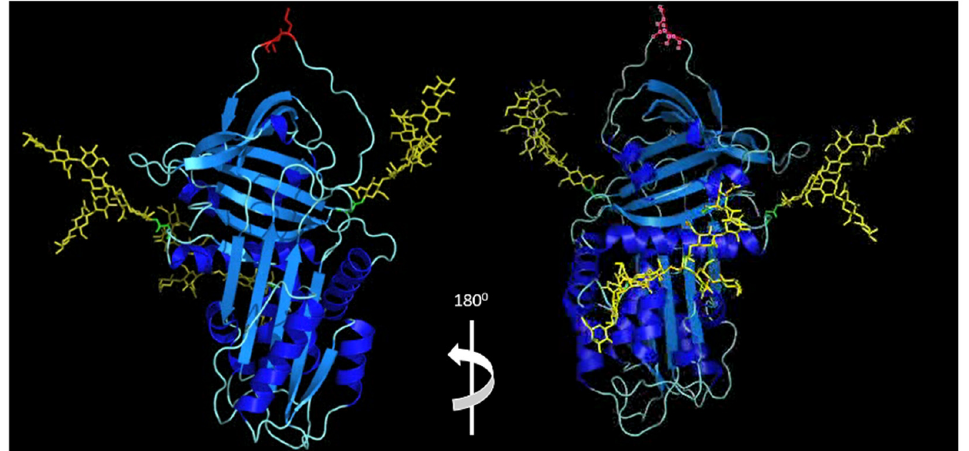
Figure 1. Molecular model of glycosylated alpha-1 antitrypsin. Blue—peptide; yellow—glycans; red—reactive centre loop (peptide linkage) (residues M382-S383). Methods: Molecular modelling was performed on a Silicon Graphics Fuel workstation using InsightII and Discover software (Accelrys Inc., San Diego, USA). Figures were produced using the program Pymol [43]. Protein structures used for modelling were obtained from the pdb database and the structure of glycosylated AAT was based on the crystal structure of human alpha-1 antitrypsin as previously described [44]. The AAT molecule is post-translationally modified by N -glycosidically linked oligosaccharides at three asparagine residues at positions 70, 107 and 271.